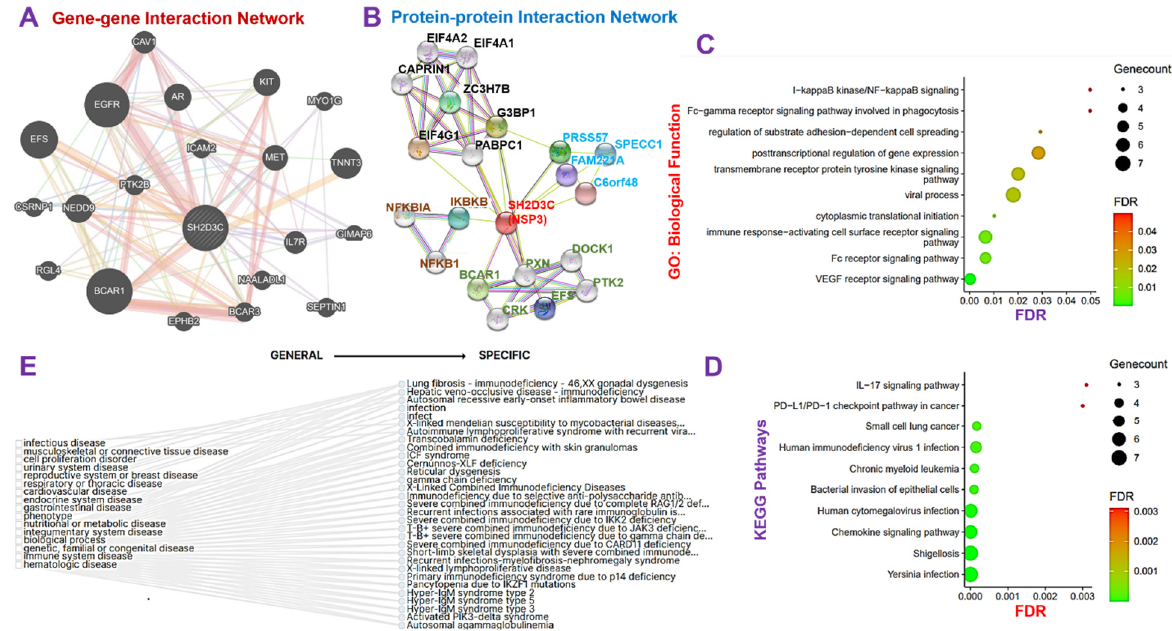
Figure 3. Non-structural protein 3 ( NSP3; SH2D3C ) elicits its pathological role via modulation of various components of the immune and inflammatory pathways in lung cancer. ( A ) Gene − gene interaction (GGI) and ( B ) protein − protein interaction (PPI) network of NSP3 . ( C ) The Kyoto Encyclopedia of Genes and Genomes and ( D ) G.O. biological function enrichments of the NSP3 network proteins. (E) Gene-diseases associated tree plot of NSP3 .